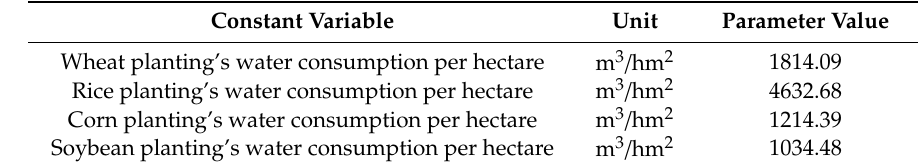
Table 2. Main parameter values of the food